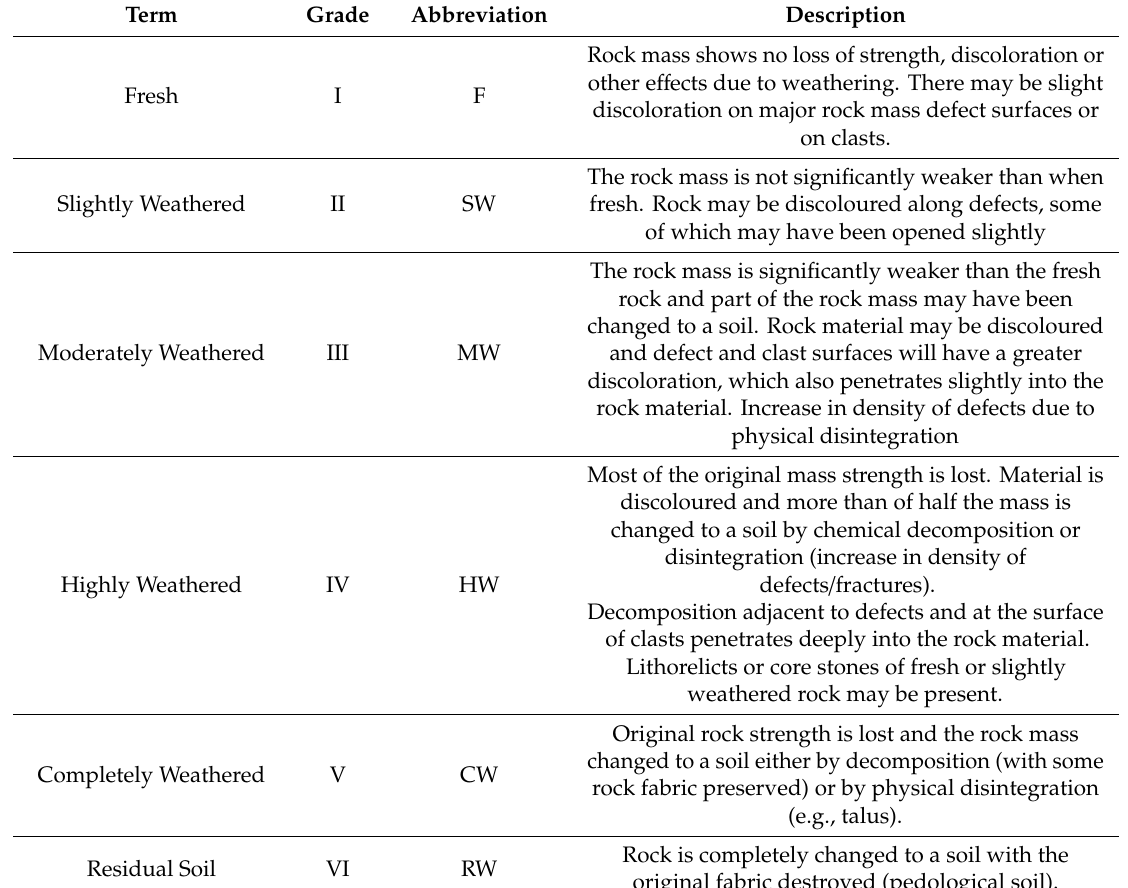
Table 3. Scale of weathering grades of rock mass (modified from Irfan and Dearman